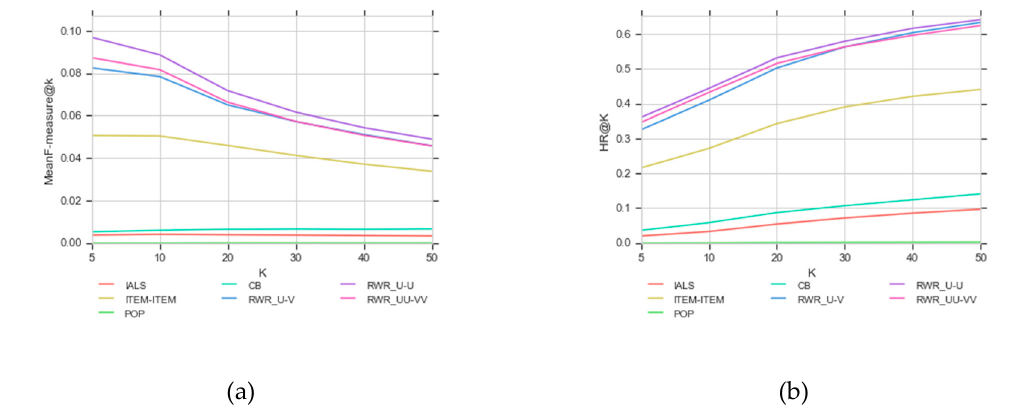
Figure 5. Performance of five recommending algorithms of matrix factorization with Implicit Alternating Least Squares (iALS), item-based collaborative filtering (ITEM-IEM), item popularity (POP), content-based recommender (CB), and RWR as measured by: ( a ) Mean F-measure@K and ( b ) HR@K. 1 https://turi.com/